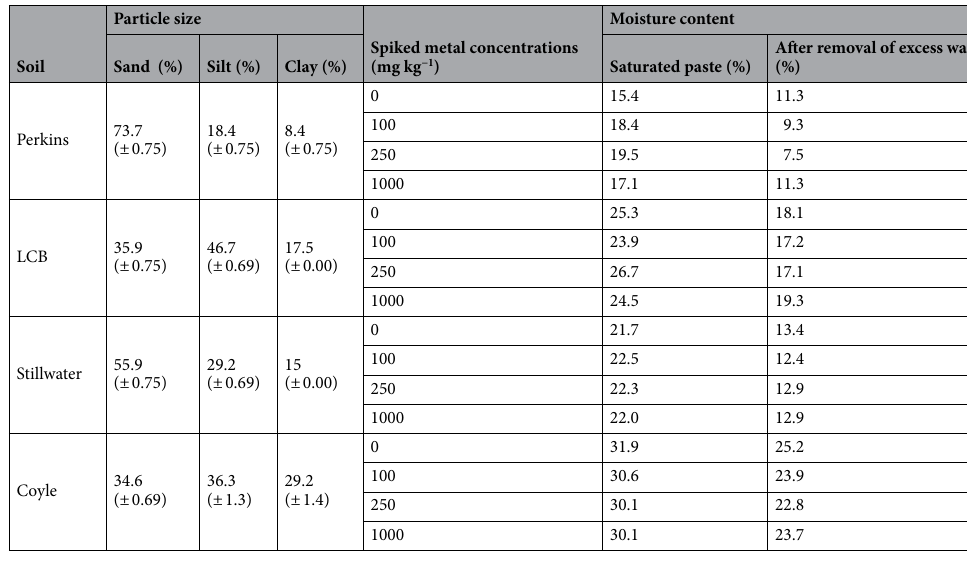
Table 1. Particle size distribution, and moisture content in saturated paste and after removal of excess water from the saturated paste of the four soils used. The soils were spiked with multiple metals for method development and validation. Moisture content is based on wet weight. ± is followed by the standard deviation of triplicates (n =